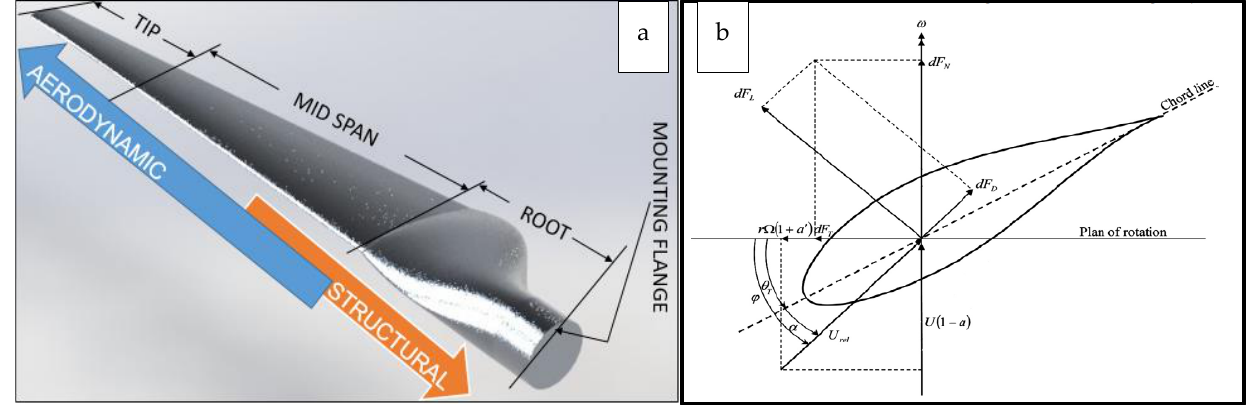
Figure 1. ( a ) The aerodynamic shape of the blade and ( b ) the analysis of the forces acting on the wind turbine blade via the wind speed.